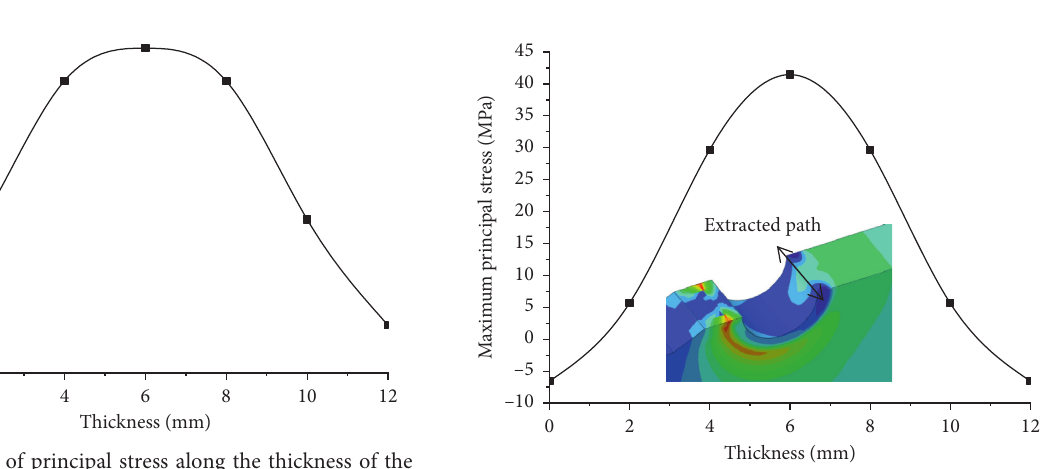
Figure 9: The trend of stress along the thickness of the hole under the preload.